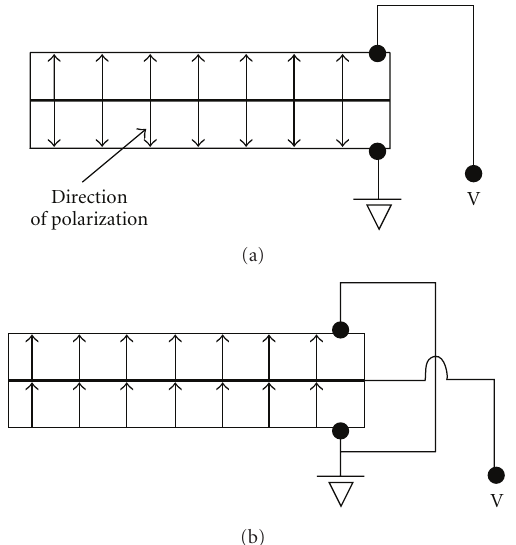
Figure 3: (a) Series and (b) parallel type configuration for bender elements.